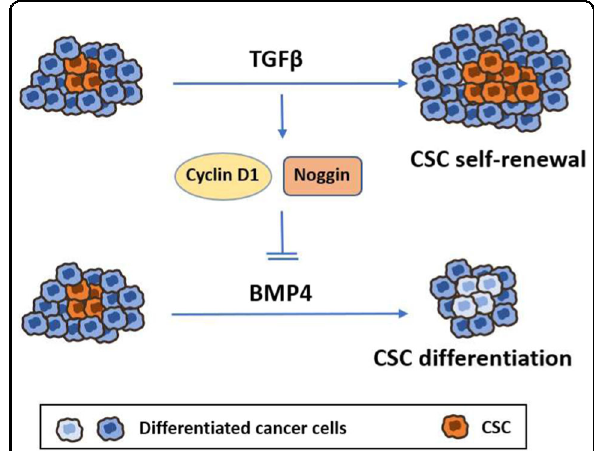
Fig. 7 Novel BMP4/TGF β interplay in the regulation of cancer stemness. Graphical representation of the TGFB, BMP4, and noggin feedback-loop mechanism in regulating cancer stem cell self-renewal activity in